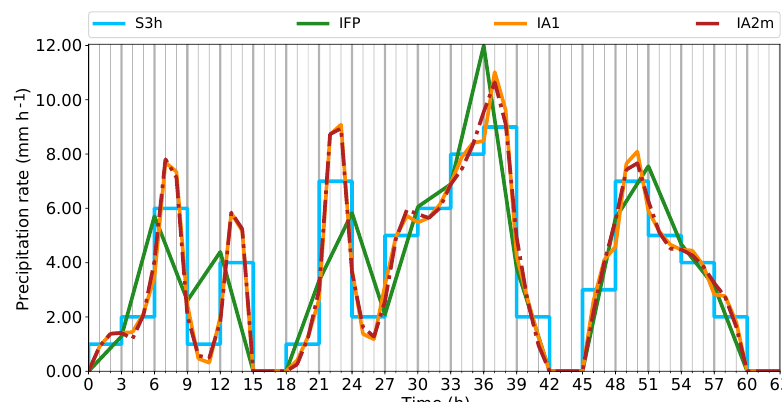
Figure 13. Verification of the different behaviour of the interpolation algorithms for a complex synthetic precipitation time series. S3h is the input data series with 3h resolution (light blue), IFP is the linearly interpolated curve according to the current scheme in FLEXPART (green), while IA1 (orange) and IA2m (red; dashed–dotted) are the reconstructions using the new